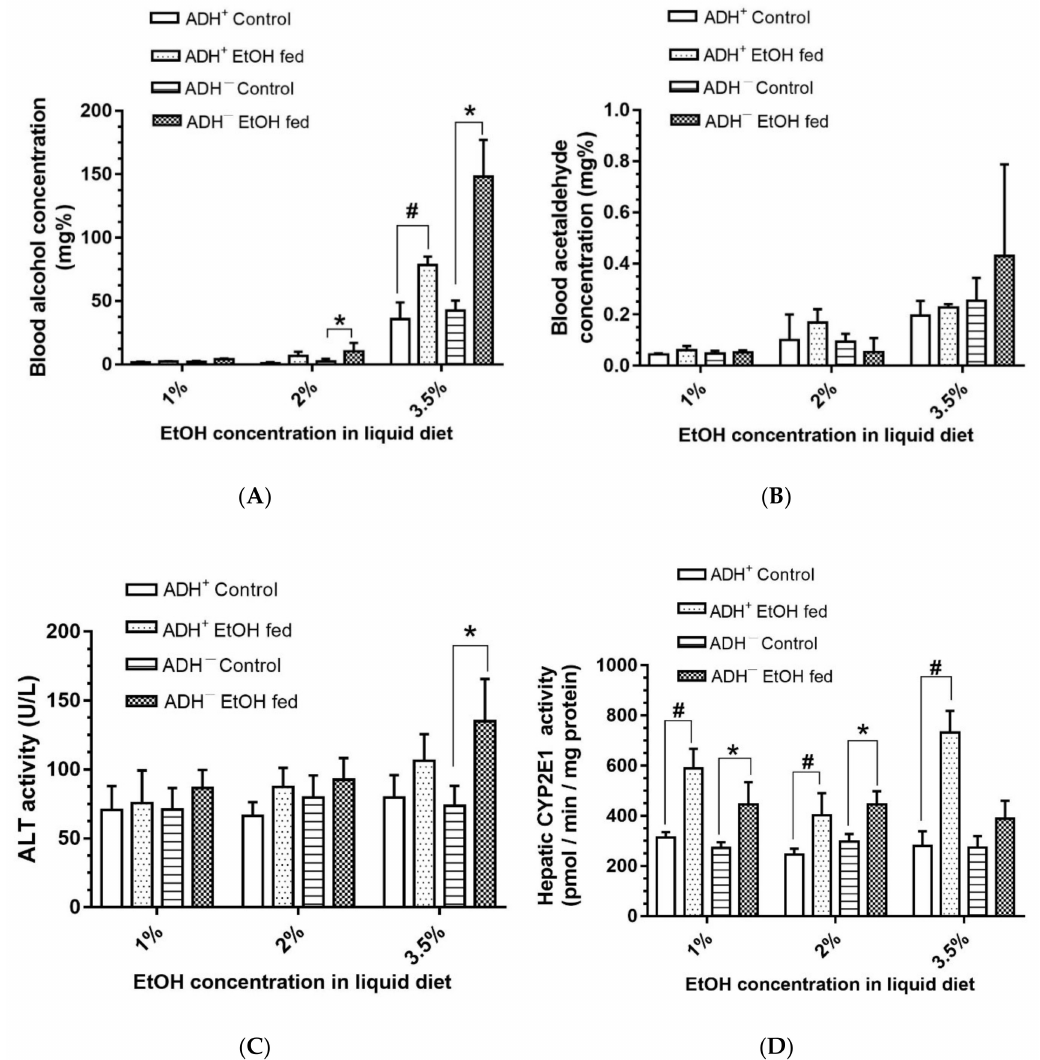
Figure 3. Levels of blood alcohol ( A ), blood acetaldehyde ( B ), plasma ALT activity ( C ) and hepatic CYP2E1 ( D ) in ADH + and ADH − deer mice fed 1%, 2% or 3.5% EtOH daily for 2 months. Values are means ± SEMs ( n = 5). * p ≤ 0.05 for EtOH-fed ADH − versus pair-fed control ADH − deer mice. # p ≤ 0.05 for EtOH-fed ADH + versus pair-fed ADH + deer